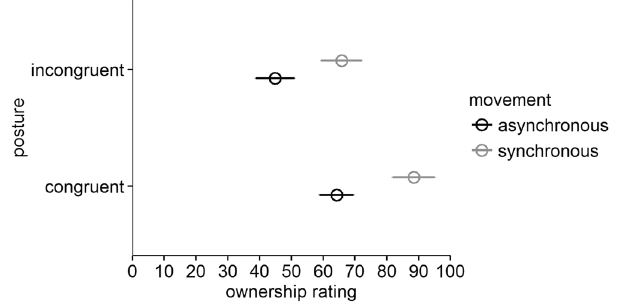
Figure 4. Mean ownership ratings in Experiment 1. Higher ratings indicate that the viewed hand was more strongly felt as the viewer’s own